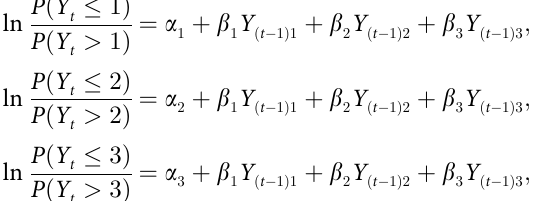
when k � = 100, 200, ... , 900, n = 1000. A